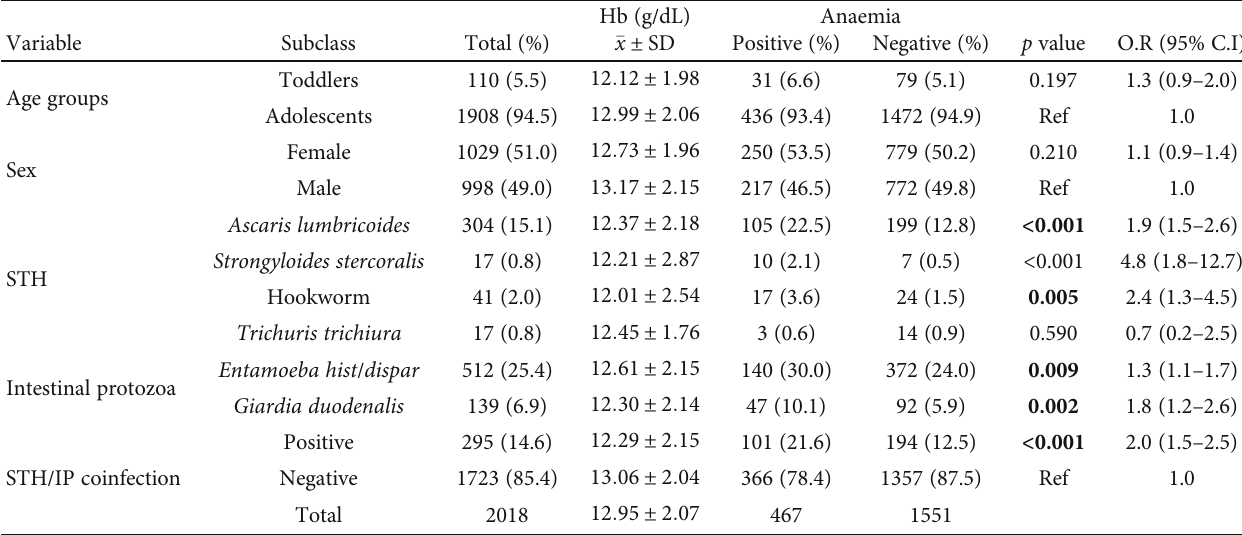
Table 3: Association of haemoglobin with age, sex, and intestinal